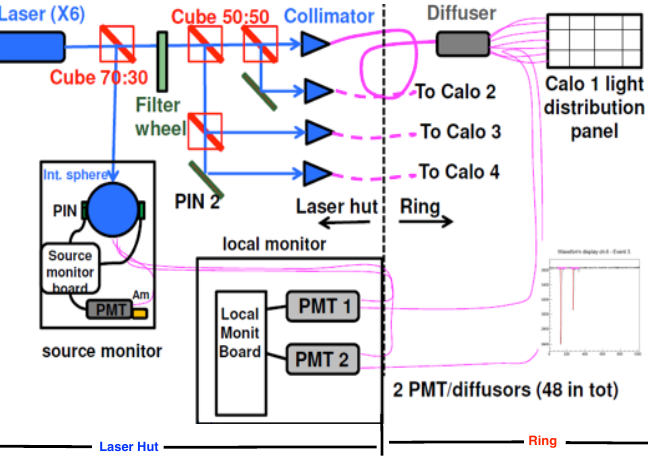
Figure 7. A schematic showing the laser calibration